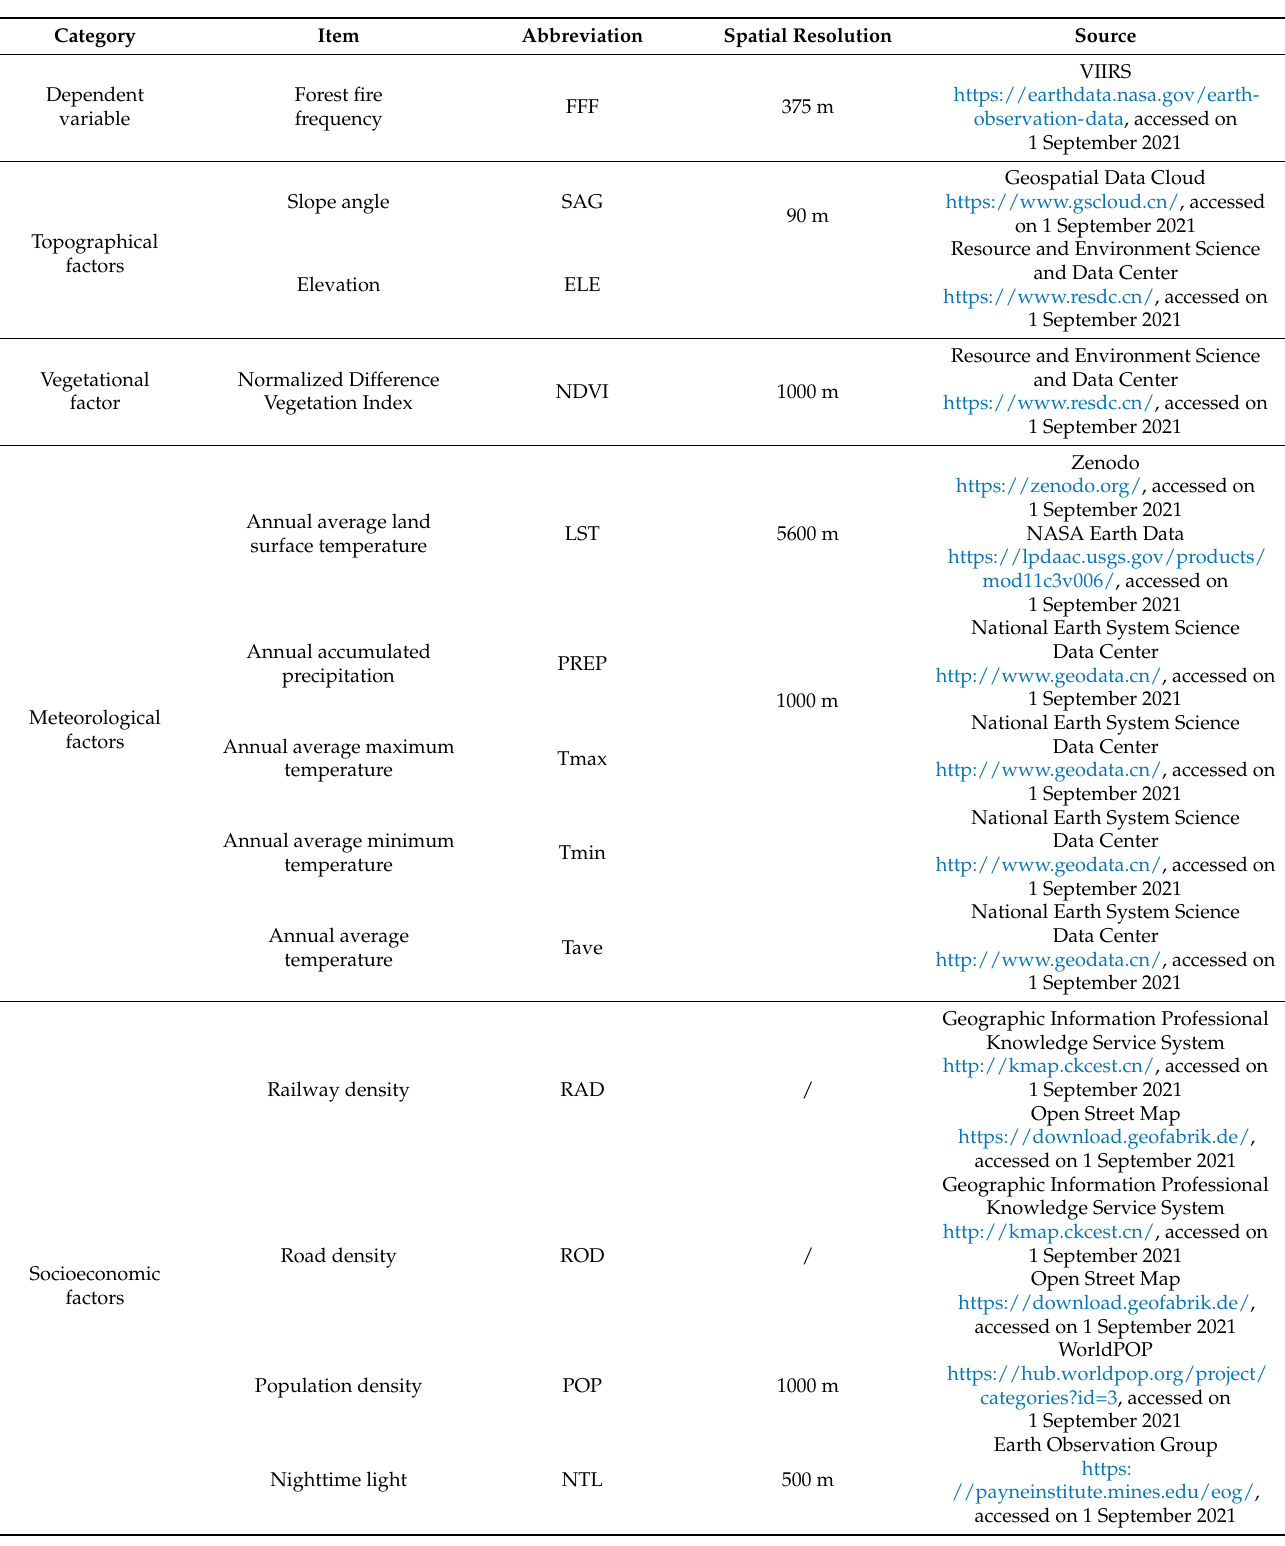
Table 1. Description and source of the data used in this